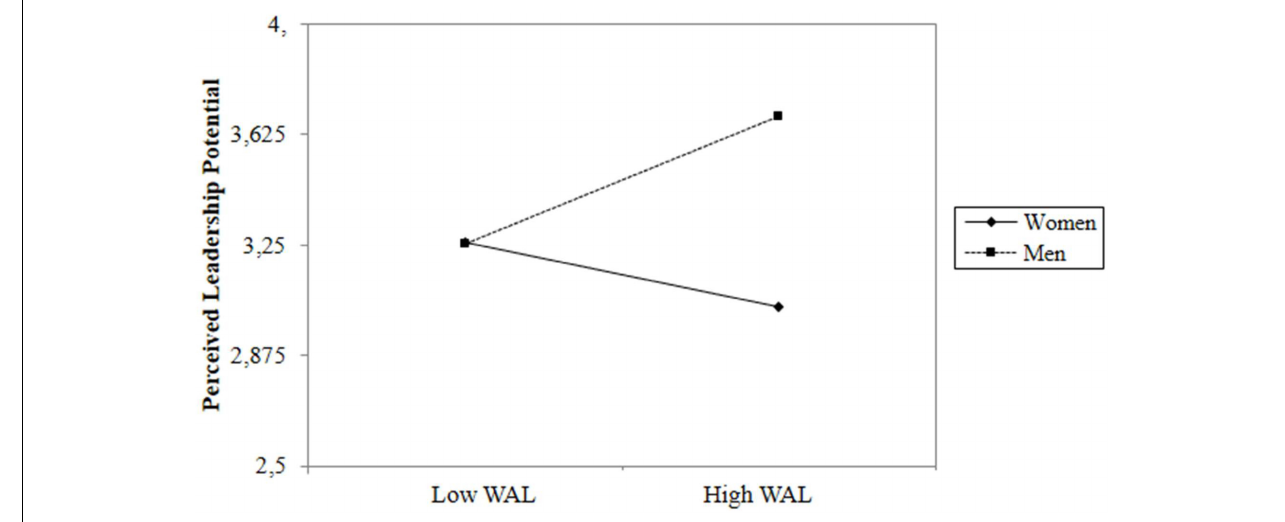
FIGURE 3 | Interaction effect between WAL and gender on perceived leadership potential in Study